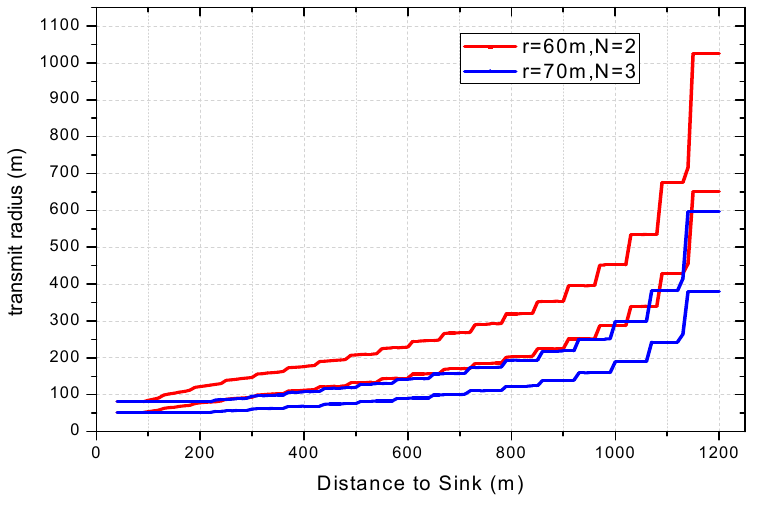
Figure 16. Transmission radius of node at different distance in COOR(R) method.